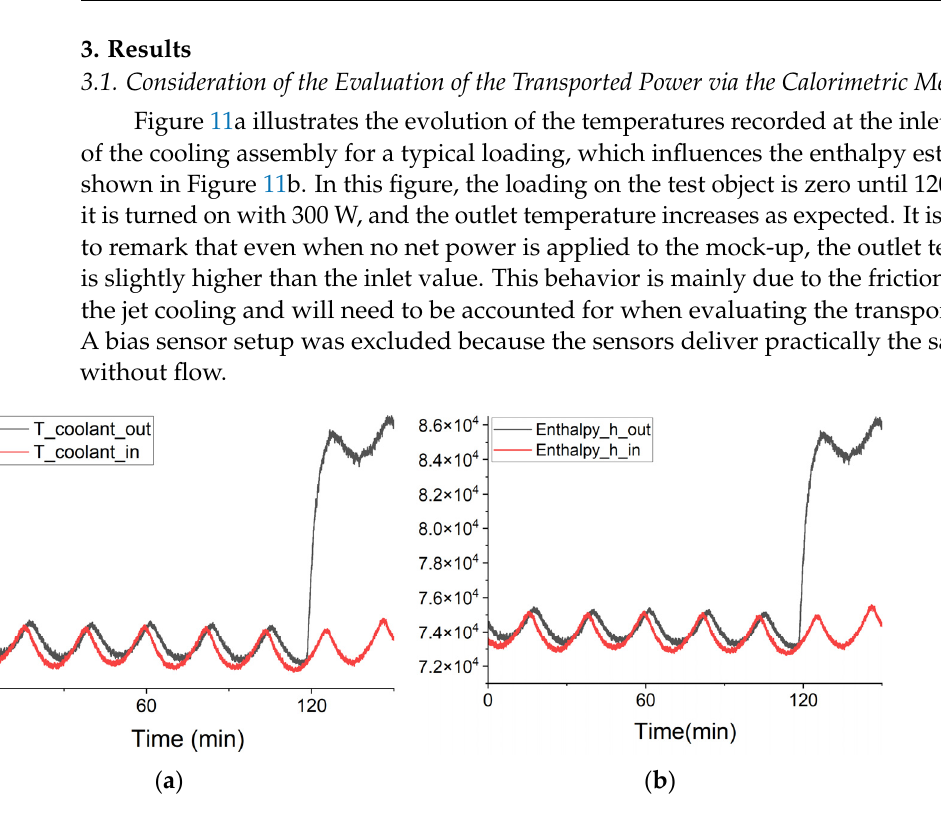
Figure 11. Transient measurement at the coolant inlet and outlet with laser power of 300 W: ( a ) temperature; ( b ) enthalpy.